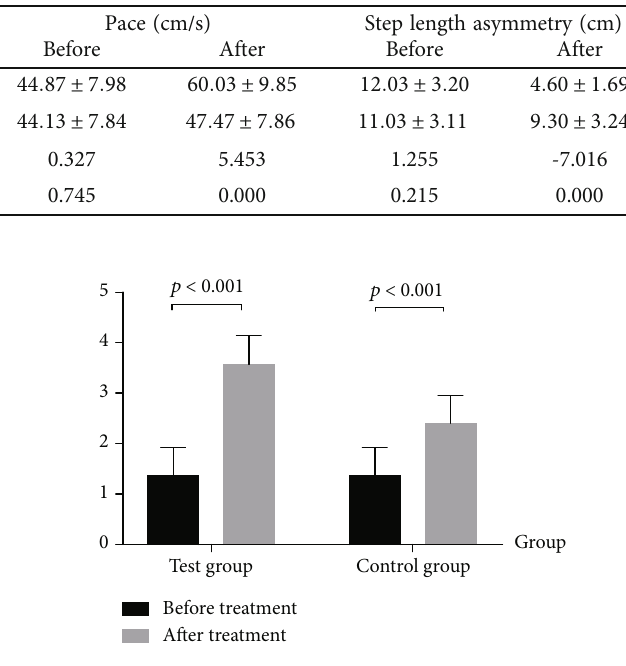
Figure 2: Comparison of two groups of FAC before and after